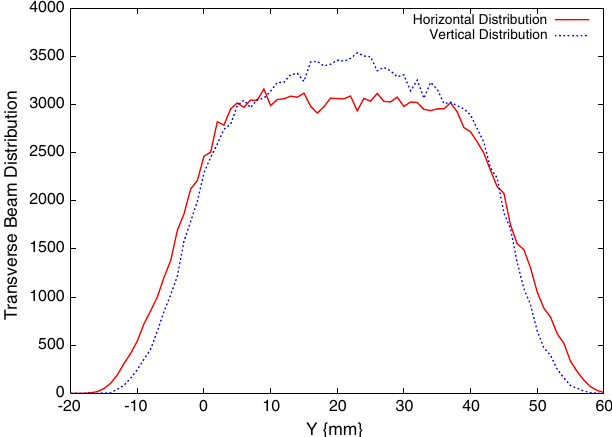
FIG. 4. Transverse profiles at beam center for the SNS coasting beam obtained from the ORBIT injection